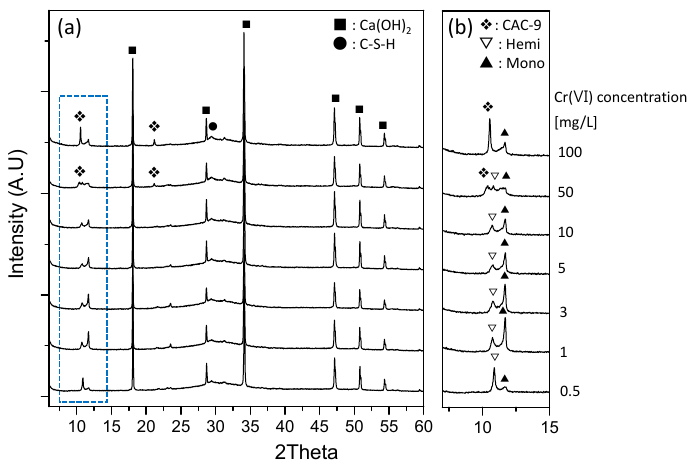
Figure 6. ( a ) XRD patterns of GGBS-CH-S3 in solutions containing 0.5 to 100 mg/L of Cr(VI) and ( b ) the magnified XRD patterns in the range of 9 to 15 degrees.